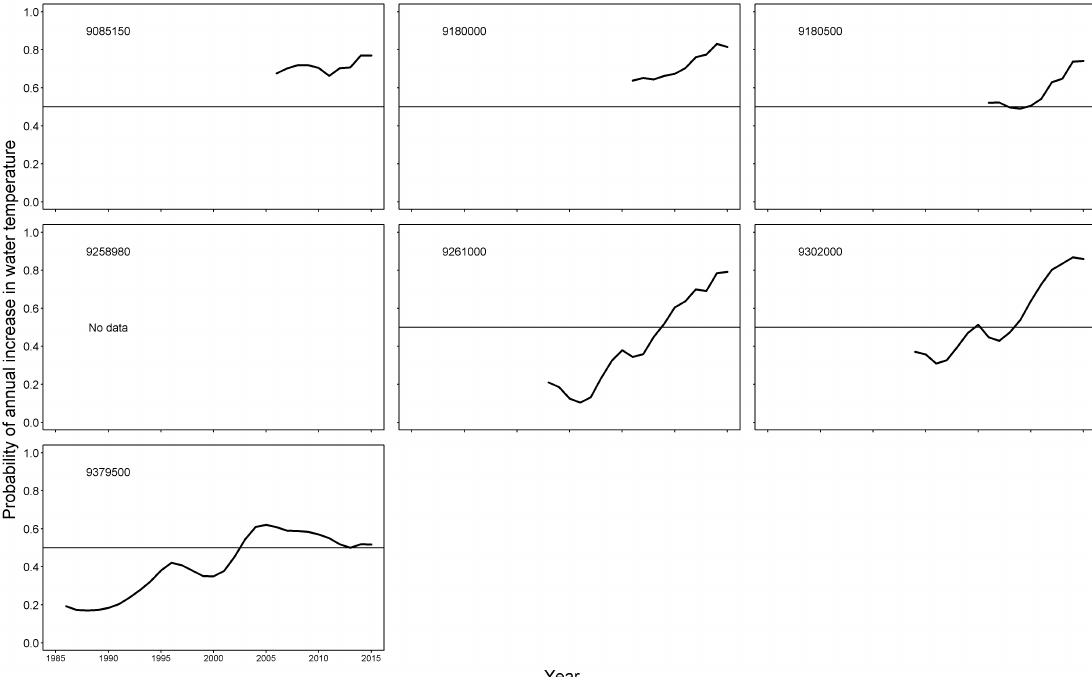
Figure 6. Annual rates of change in winter river water temperature for sites located in the Upper Colorado River Basin (see Figure 1 for the site map). Solid lines are posterior means, and shaded areas are 95% credible regions. Numerical codes on each panel correspond to the U.S. Geological Survey gauge ID.